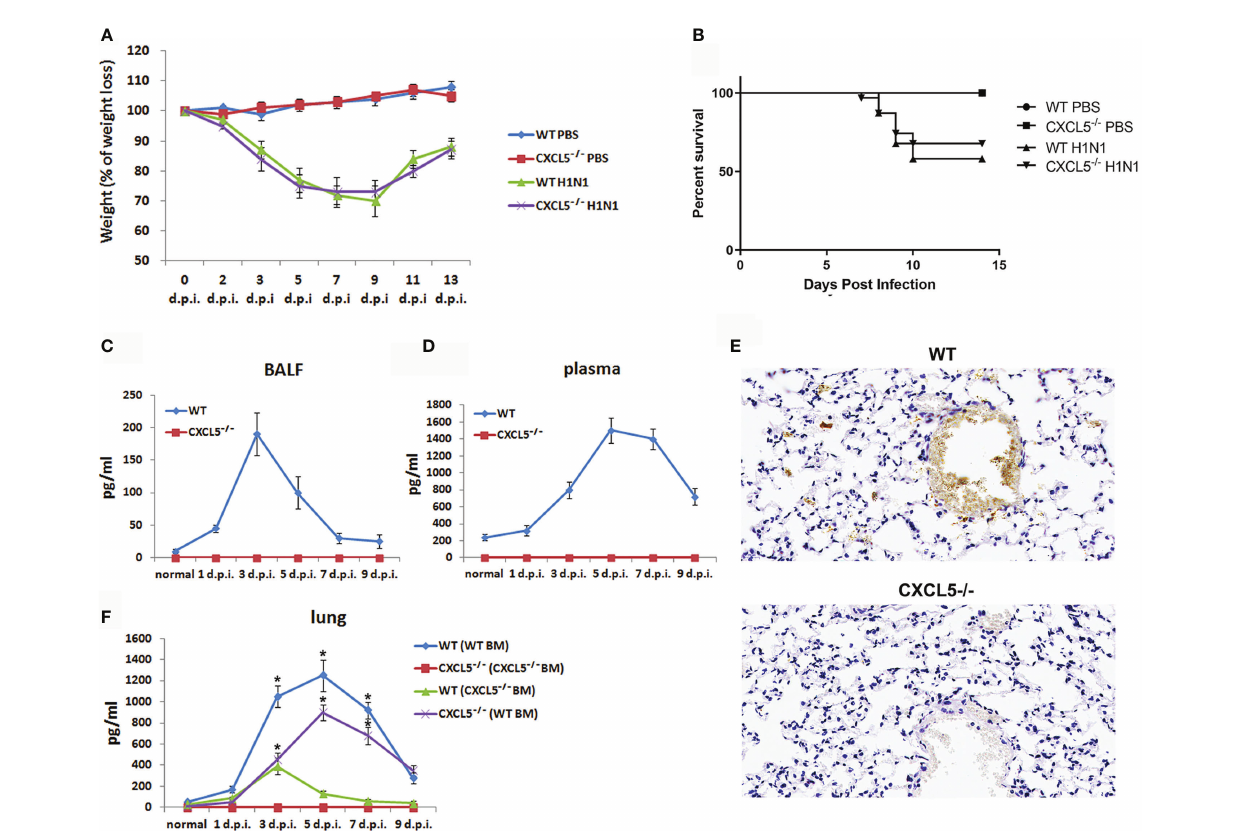
FIGURE 1 | Respiratory H1N1 infection mouse model and CXCL5 protein production in infected lungs. WT mice, CXCL5 -/- mice and BM reconstitution mice were infected with H1N1 virus (1000 CCID 50 ), and PBS instillation was used as a control. (A) The body weight loss of the mice (n=16) was monitored until 2 weeks post infection. (B) Kaplan-Meier survival curve for the infected mice (n=31). (C) CXCL5 levels in the BALF of the infected mice were measured by ELISA (n=5). (D) CXCL5 levels in the plasma of the infected mice were measured by ELISA (n=5). (E) Lung sections from infected WT and CXCL5-/- mice were stained at 3 d.p.i. with anti- CXCL5 antibody and hematoxylin. (F) CXCL5 levels in the lung homogenates of the BM reconstitution mice were measured by ELISA (n=4). WT(WT BM): WT recipient mice reconstituted with BM from WT donor mice; WT(CXCL5 -/- BM): WT recipient mice reconstituted with BM from CXCL5 -/- donor mice; CXCL5 -/- (CXCL5 -/- BM): CXCL5 -/- recipient mice reconstituted with BM from CXCL5 -/- donor mice; CXCL5 -/- (WT BM): CXCL5 -/- recipient mice reconstituted with BM from WT donor mice. The error bars represent the SDs. *P < 0.05 based on Student ’ s t